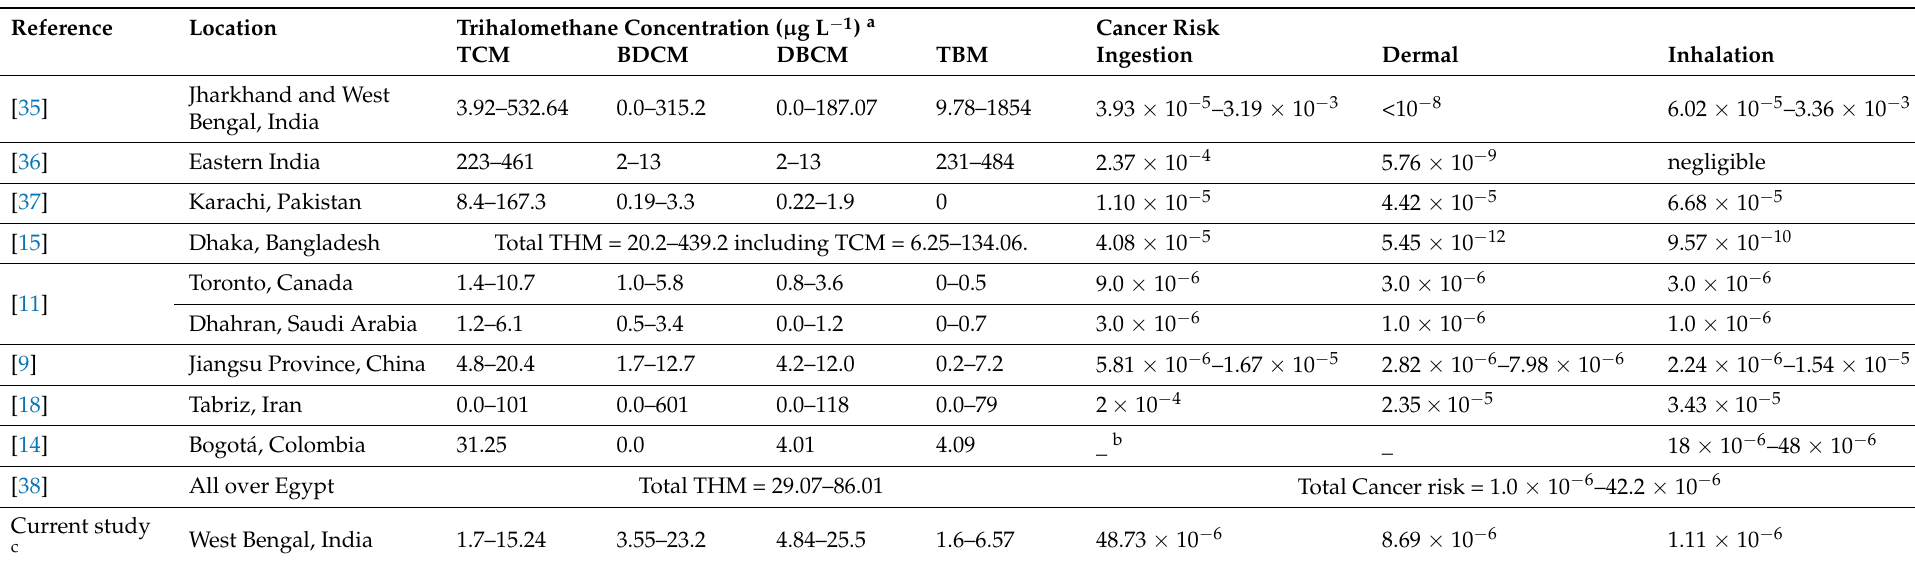
Table 4. THM concentration in various water supply systems and their associated cancer